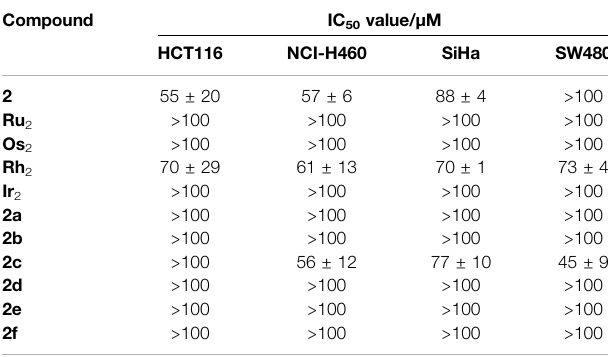
TABLE 2 | IC 50 values (µM) complexes 2a – 2f in HCT116, NCI-H460, SiHa and SW480 cancer cell lines expressed as mean ± standard error ( n (cid:1) 3), in comparison to ligand 2 and the homodimetallic analogs Ru 2 , Os 2 , Rh 2 and Ir 2 (Steel et al., 2021).